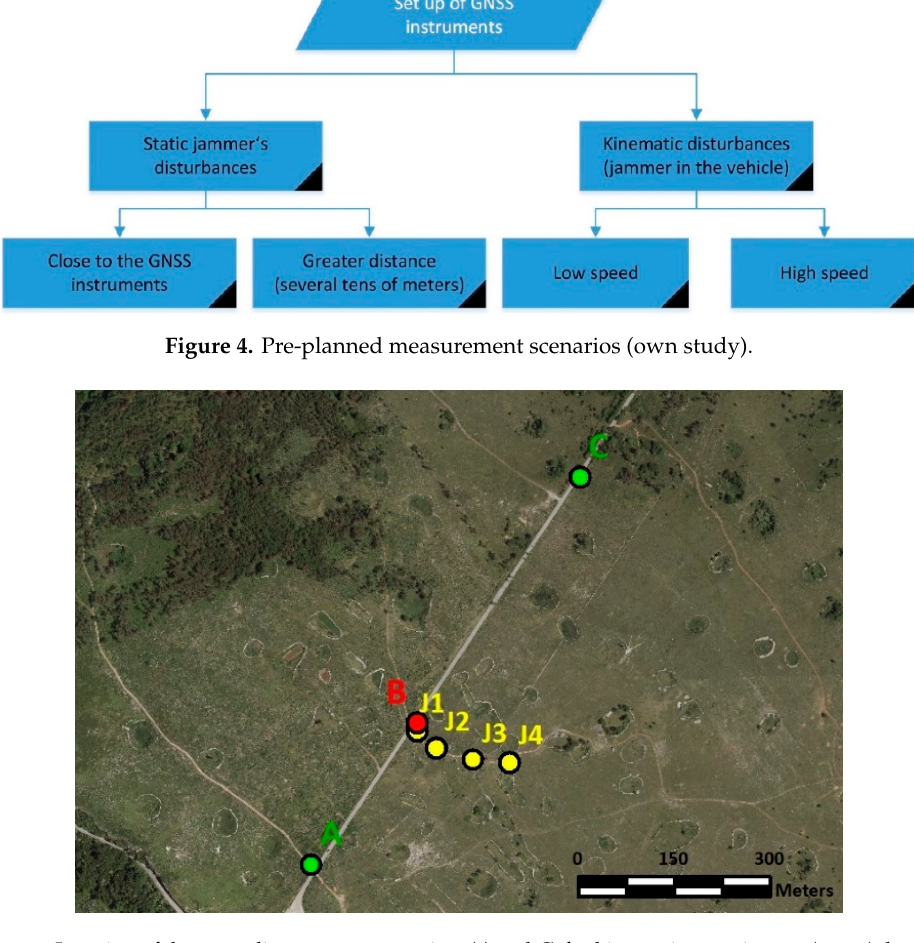
Figure 5. Location of the most distant two-way points ( A and C ) for kinematic experiments (green), location of the receivers ( B ) in red and static positions of the jammer (J1, J2, J3 and J4) in yellow (own study). Table 2. Position of the jammer in static mode (3-minute jammings, where the jammer remained fixed in a certain position). Heights H were acquired from the ellipsoidal heights by using the SLO_VRP2016/Koper geoid model.